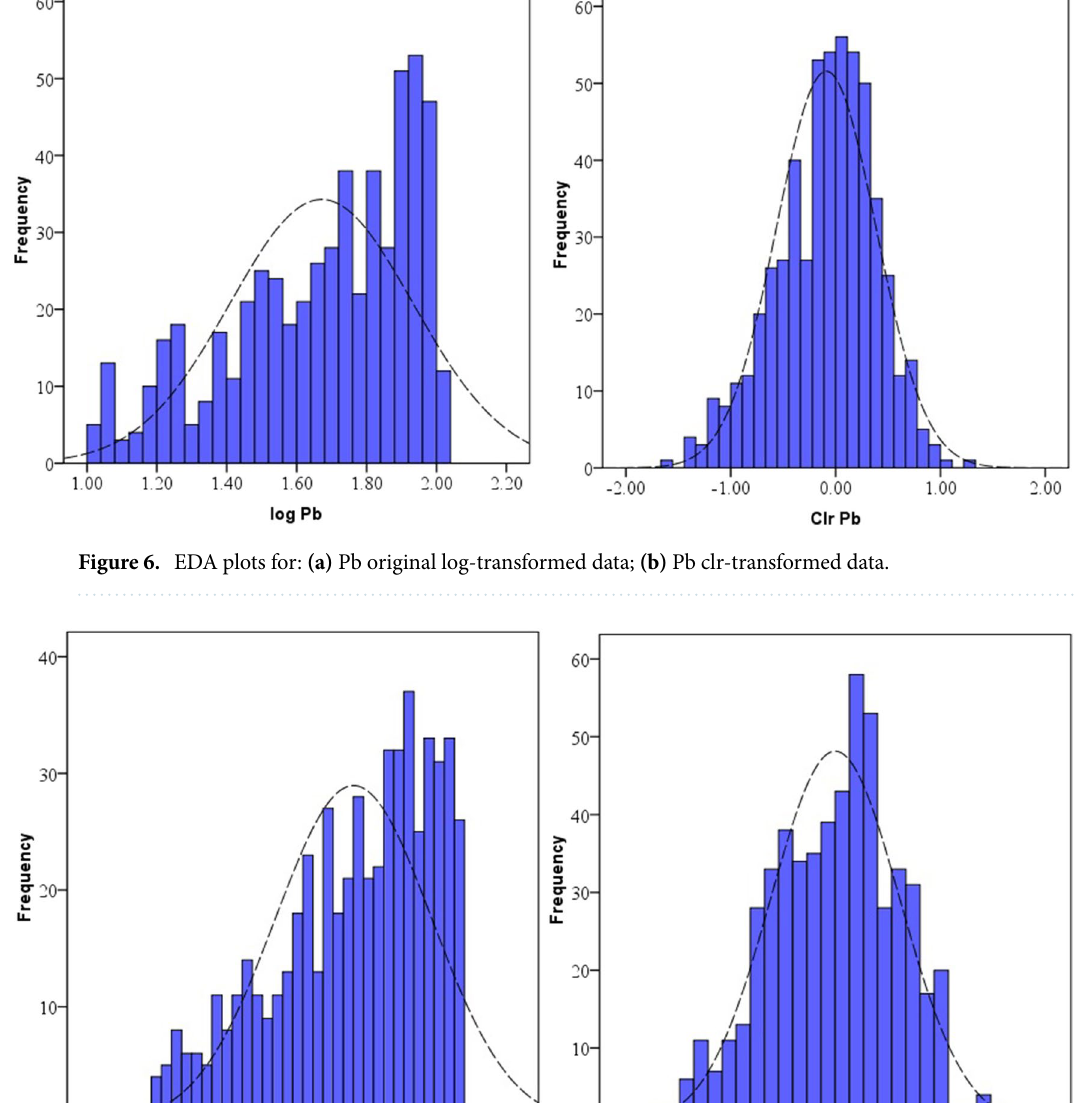
Iran. Each raster map with the corresponding element threshold value was divided for residential use: 100 mg/ kg for Pb, 120 mg/kg for Cu and 150 mg/kg for Zn.